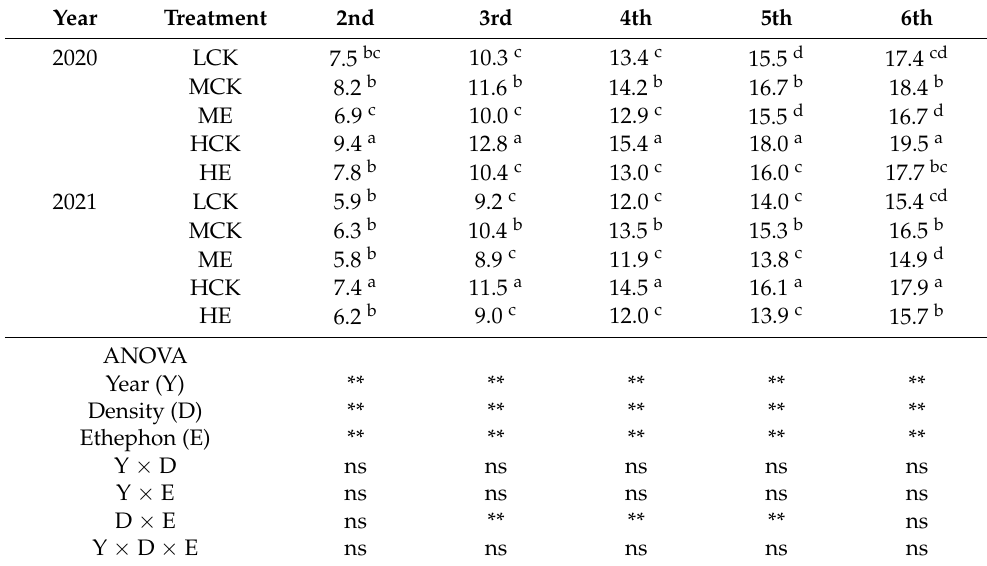
Table 2. Effects of spraying ethephon on internode length (cm) of summer